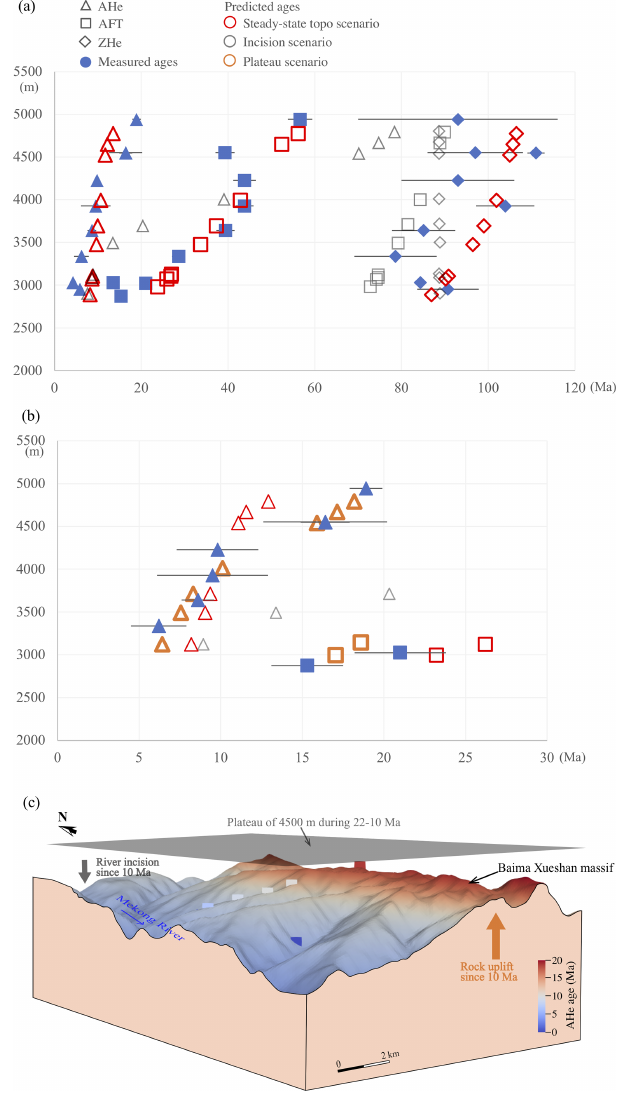
Figure 3. Model results for the Baima Xueshan massif. (a) Age– elevation profiles of measured (solid blue symbols; triangles, squares, and diamonds corresponding to AHe, AFT, and ZHe ages, respectively) and predicted (open symbols coloured according to scenario) ages for the steady-state topography and incision sce- narios. (b) Age–elevation profile of measured AHe and AFT ages ( < 22Ma) and predicted ages for the plateau scenario and pre- dictions of the scenarios shown in (a) for comparison. (c) Three- dimensional view of the present-day topography (at resolution of 900m) of the Baima Xueshan massif above the Mekong River, coloured according to predicted AHe ages for the plateau scenario, the best-fit model for Baima Xueshan transect (orange symbols in b ). Note that the plateau is shown slightly higher than its real elevation for clarity. The squares indicate the sample